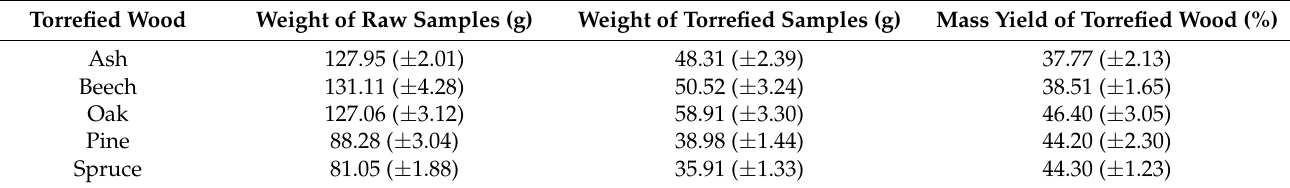
Table 1. The mass of samples before and after the torrefaction.